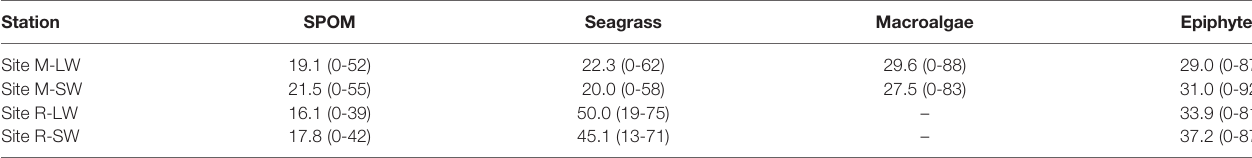
SPOM, suspended particulate organic